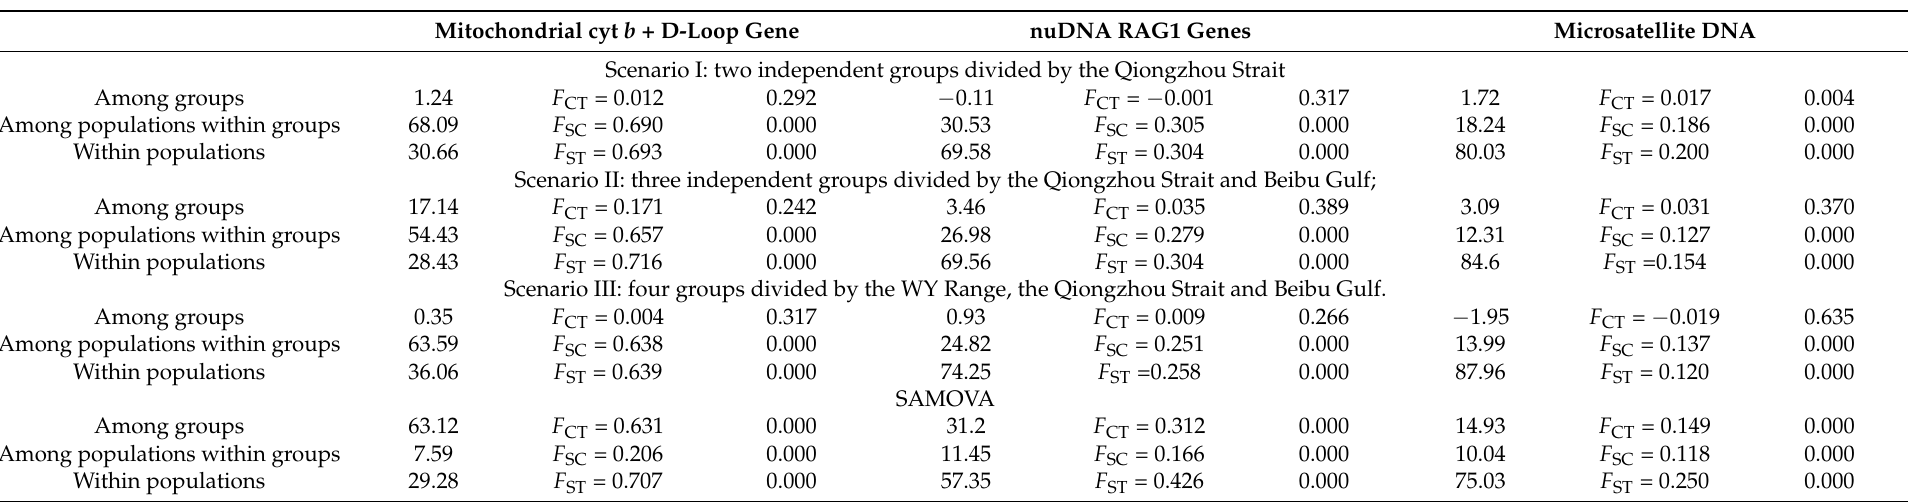
Table 2. Analysis of molecular variance (AMOVA) for O. hainanensis based on mitochondrial, nuclear, and microsatellite data. Mitochondrial cyt b + D-Loop Gene nuDNA RAG1 Genes Microsatellite